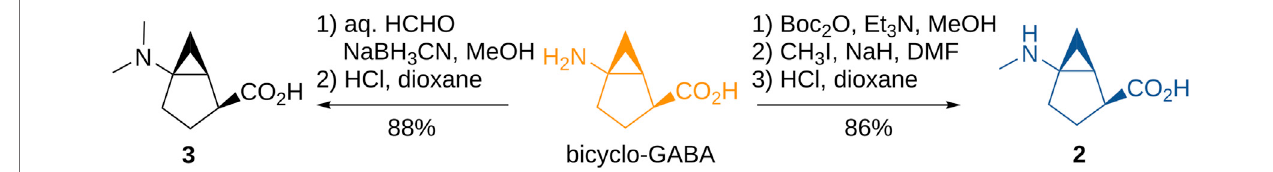
FIGURE 3 | Synthesis of N -methylated bicyclic GABA analogs.